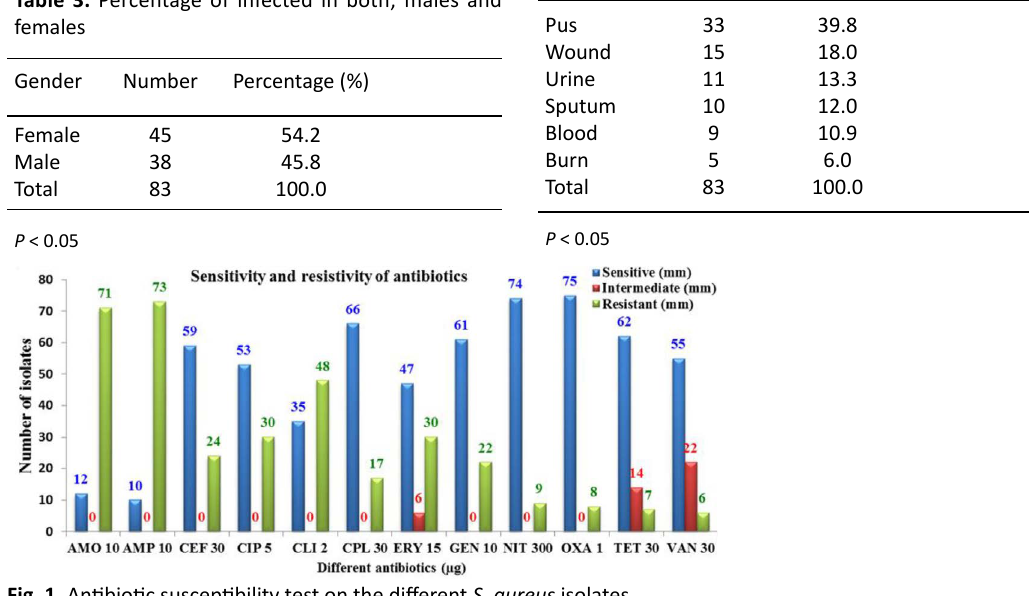
Table 3. Percentage of infected in both; males and